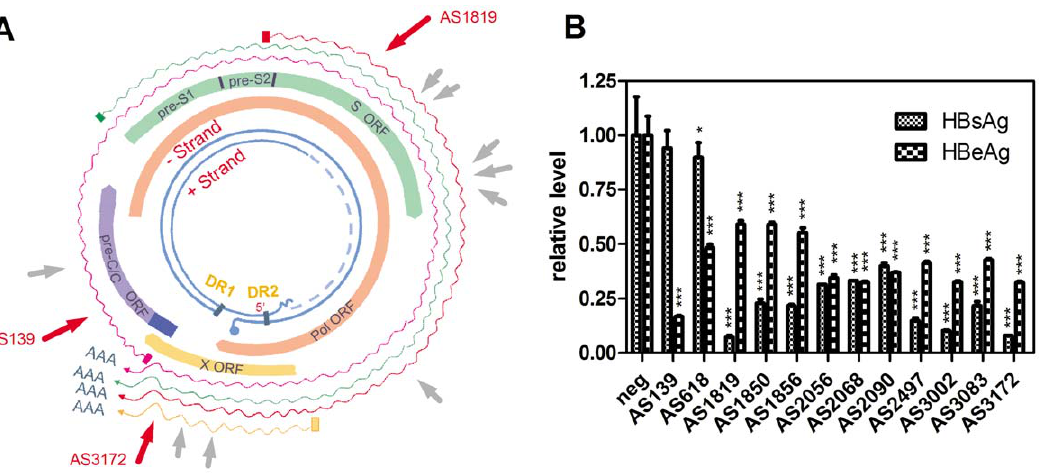
Figure 5. Screening of shRNAs for significant suppression of HBsAg and HBeAg. (A) shRNAs targeting to the conserved regions of HBV genome were designed and illustrated. The numbers represent nucleotide (nt) coordinates relative to the HBV (genotype B) pgRNA start site. (B) HepG2 cells were seeded in 24-well plates and cotransfected with 200 ng of pHBV1.31, 200 ng shRNA plasmid and 100 ng pSEAP2-Control per well. The HBsAg and HBeAg concentrations in cell supernatants were detected 48 h post transfection. Means and standard deviations were generated from 3 independent experiments.